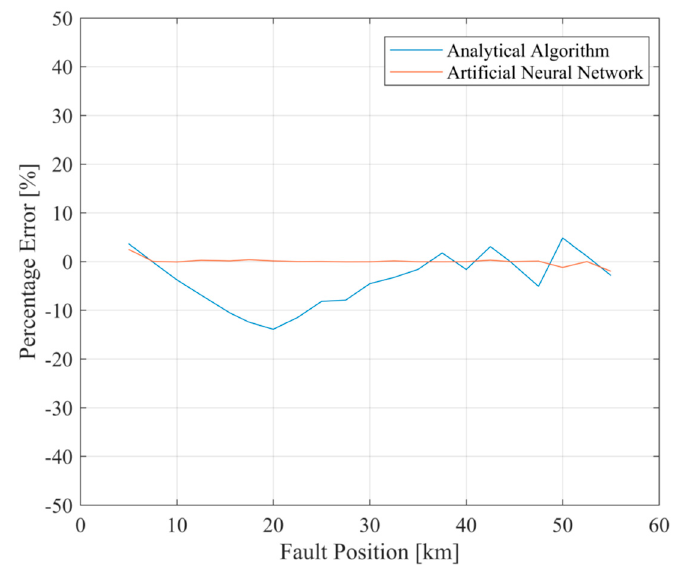
Figure 9. Percentage error vs fault distance for both algorithms.